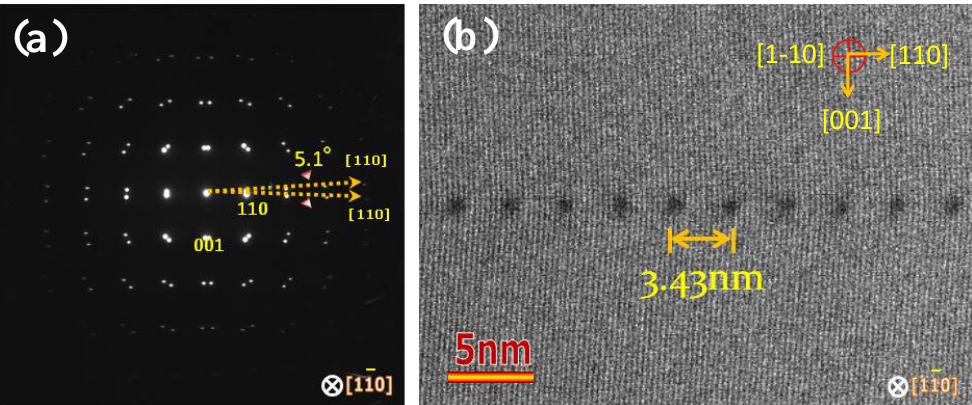
Figure 25. ( a ) Selected-area diffraction pattern (SADP) taken from the boundary area. An overall symmetry is seen in the pattern, indicating a perfect joining of the two single crystals; ( b ) Low-magnification ADF STEM image of the boundary in the bicrystal, suggesting the formation of a periodic array of dislocations at the boundary with 3.4 nm separation [32].